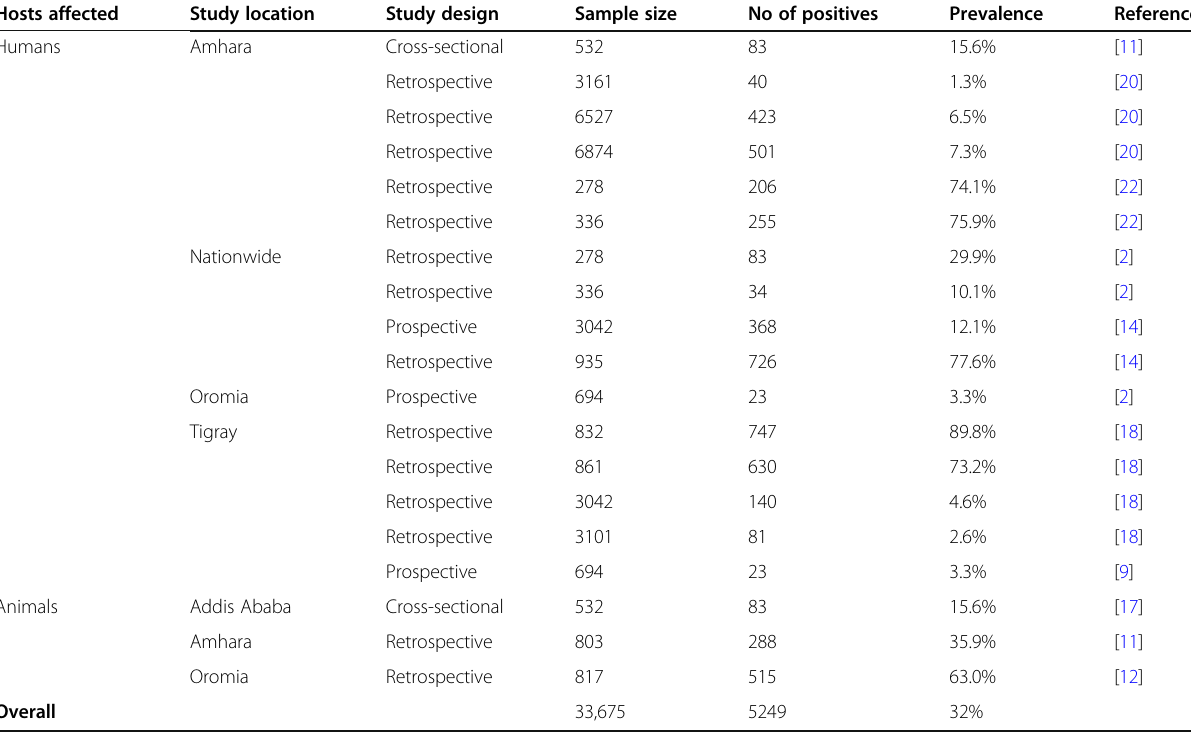
Table 1 Descriptive Metadata of rabies from 2010 to 2020 published studies in Ethiopia Hosts